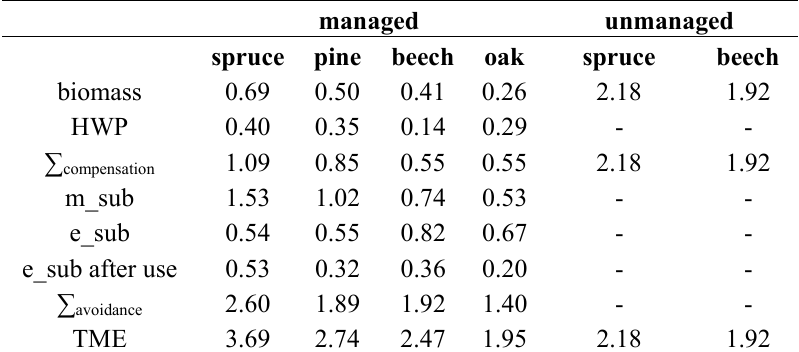
Table 4. Mean annual sequestration and substitution rates and mean annual total mitigation effects (TME) after 180 years, where biomass is living biomass and deadwood, m_sub is the substitution effect via material use of wood, e_sub is the substitution effect of fuel wood and E_sub after use is the use for fuel wood after material use; all values are in Mg ha − 1 year − 1 ; TME in the unmanaged stands consists of carbon in living biomass and